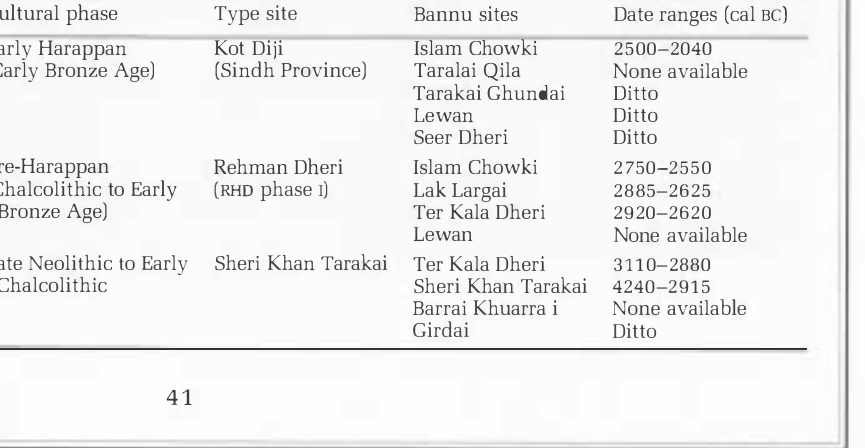
Table 1 Cultural sequence and chronology of late prehistoric sites in the Bannu